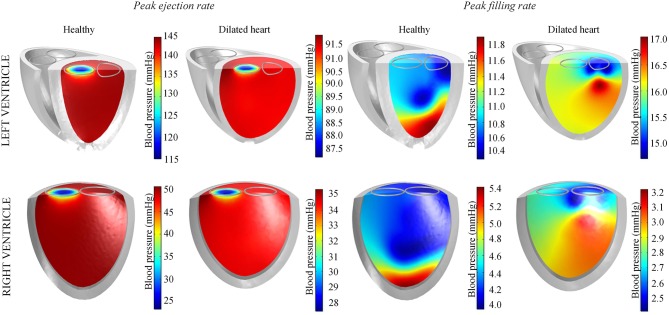
Blood pressure distribution in the left and right ventricles of the standard healthy and dilated heart models taken at timepoints of peak ejection and filling rates.